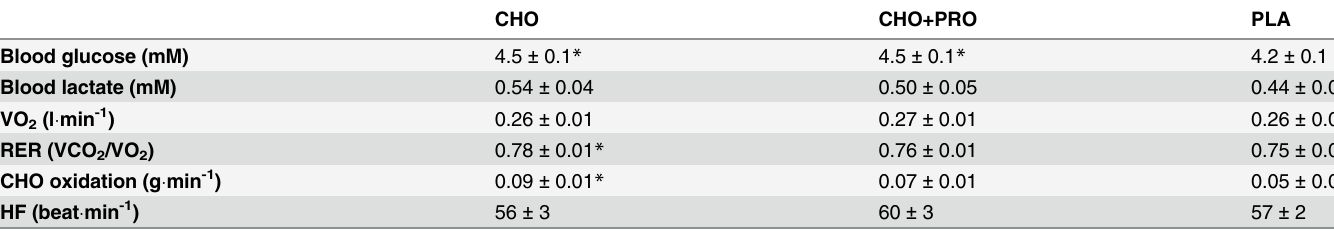
Table 2. Fasting blood glucose, lactate, VO 2 , RER, carbohydrate oxidation and HR after the three interventions.